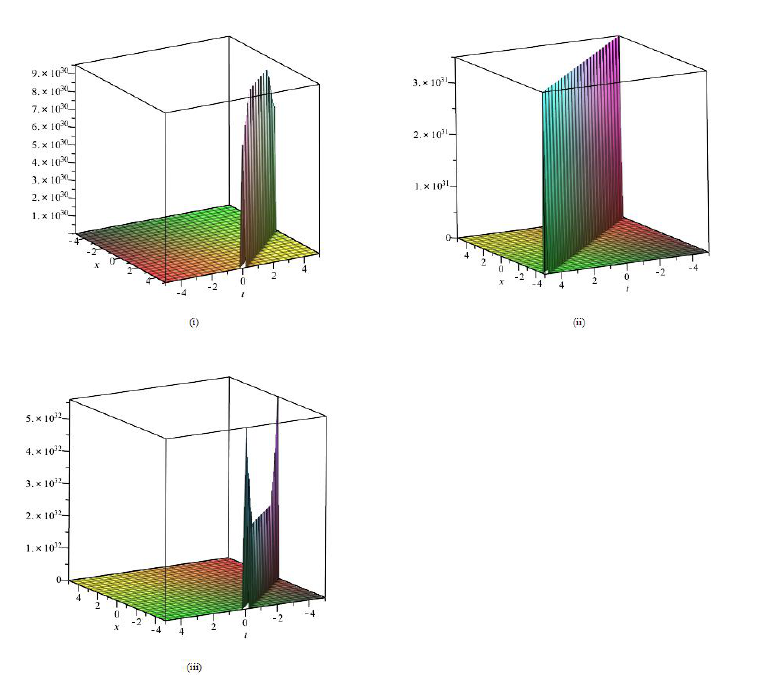
Figure 1. The 3D profiles of solution u r ( x + ν t ) of Equation (1) corresponding to ( i ) x 0 = 5, t 0 = 3,